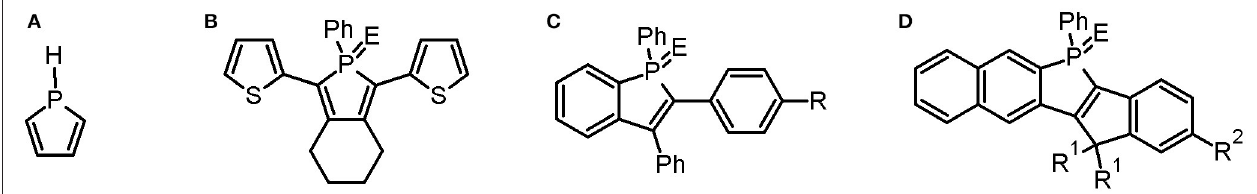
FIGURE 1 | The chemical structures for different phospholes. (A) An unsubstituted phosphole. (B) A linear phosphole substituted with thienyl groups. E = lone pair, O, S, Se, CH 3 , W(CO) 5 . (C) A fused benzophosphole. E = O, S, CH 3 . R = NPh 2 , OMe. (D) A fused naphtophosphole. E = O, R 1 = Ph-4-O-(CH 2 O) 3 -CH 3 , R 2 = NPh 2